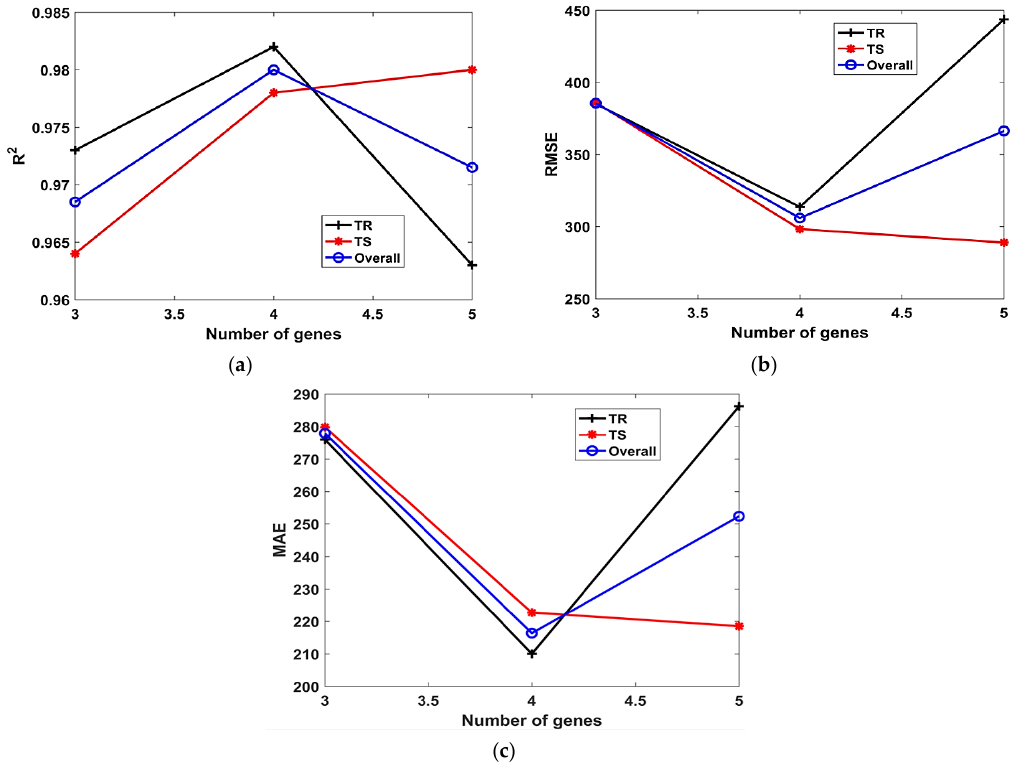
Figure 5. Effect of N g on the performance of models. ( a ) R 2 , ( b ) RMSE , ( c ) MAE .